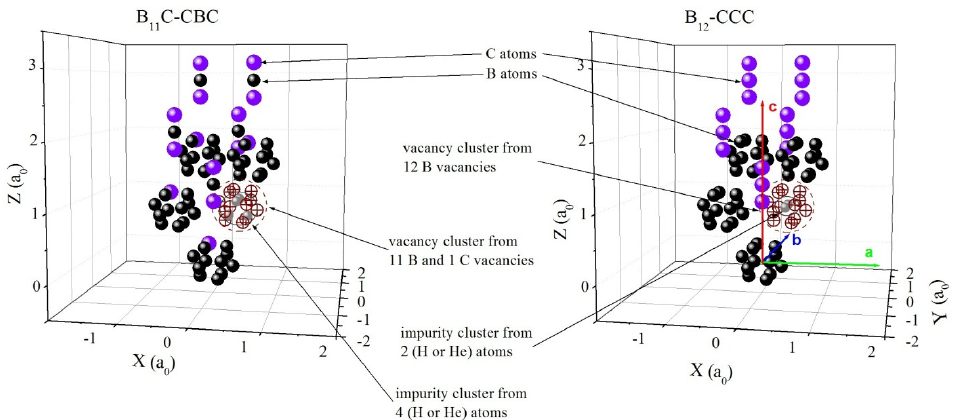
Figure 2. Visualization of super cell of B 4 C and positions of point defects in vacancy cluster from 12 vacancies impurity with H or He atoms. b = 2a 0 × sin( α /2), α = 65.981° a rhombohedral setting. There are presented two cases: fist polarized B 11 C-CBC and second B 12 -CCC.